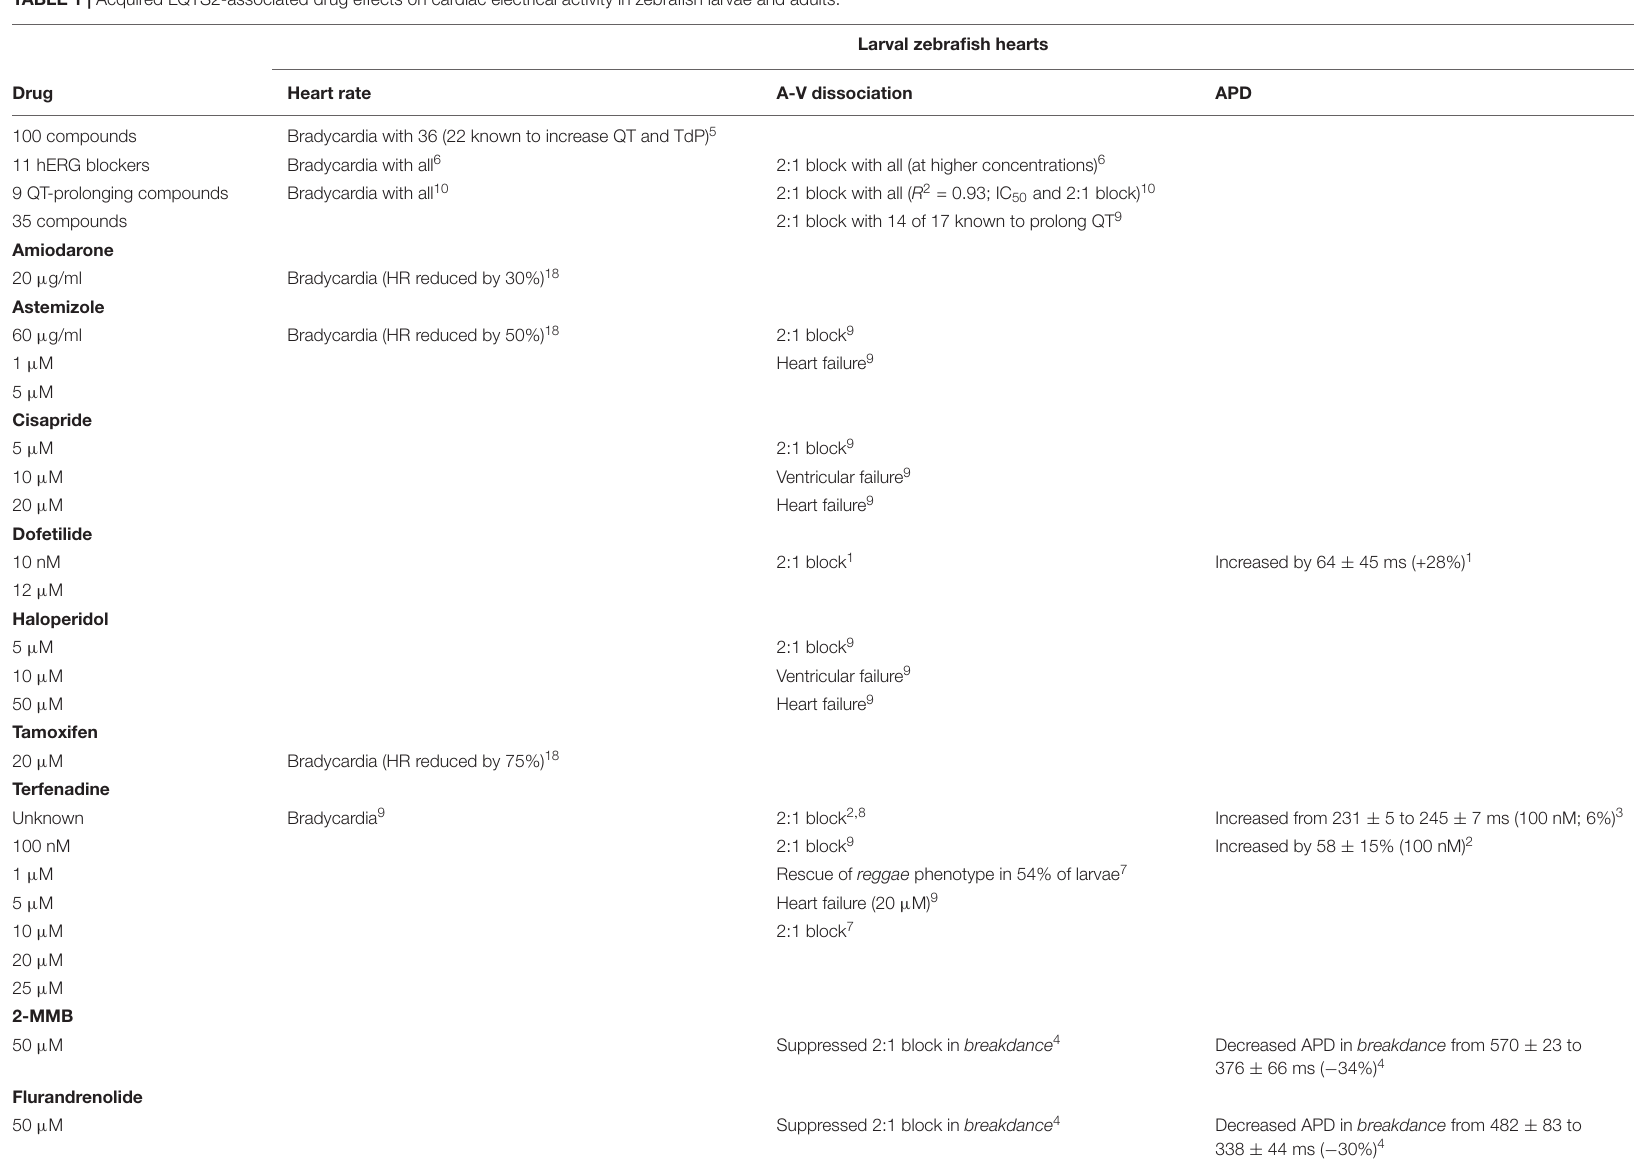
TABLE 1 | Acquired LQTS2-associated drug effects on cardiac electrical activity in zebrafish larvae and